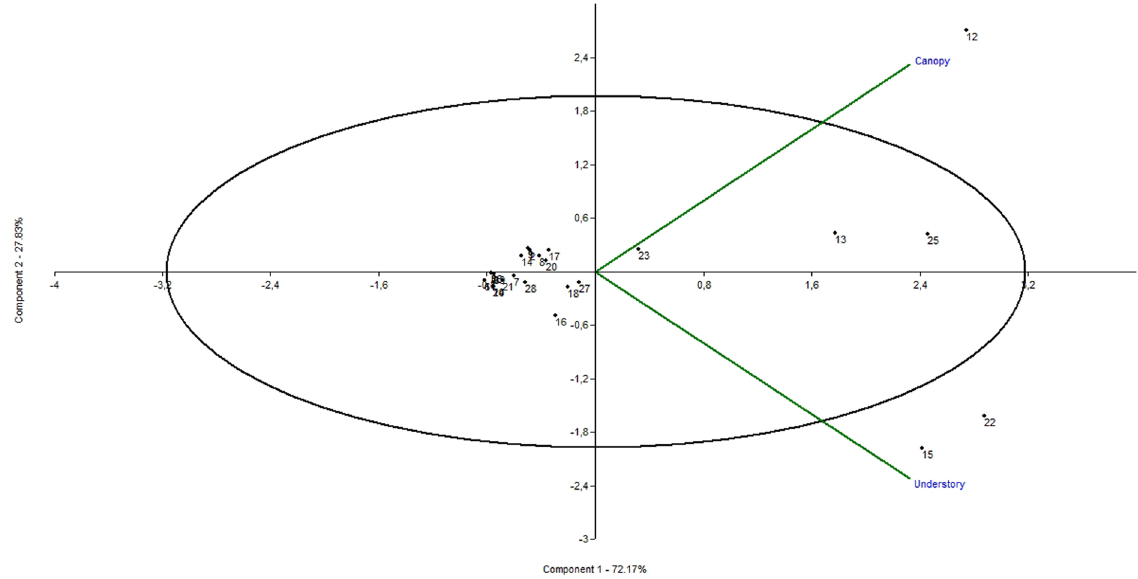
Fig 2 . Principal Component Analysis (PCA) between species and strata. Ellipse indicates 95% confidence interval. Species farther from origin of axis are more representative of each stratum. Species names: 1. E. auripes; 2. E. concava; 3. E. flaviventris; 4. E. superba; 5. E. surinamensis; 6. E. vidua; 7. E. allosticta; 8. E. amazonica; 9. E. augaspis; 10. E. avicula; 11. E. bidentata; 12. E. cognata; 13. E. cordata; 14. E. gaianii; 15. E. ignita; 16. E. intersecta; 17. E. sp; 18. E. modestior; 19. E. mourei; 20. E. viridifrons; 21. E. bombiformis; 22. E. meriana; 23. E. nigrita; 24. E. polyzona; 25. E. pseudocingulata; 26. E. dentata; 27. E. lepeletieri; 28. E.